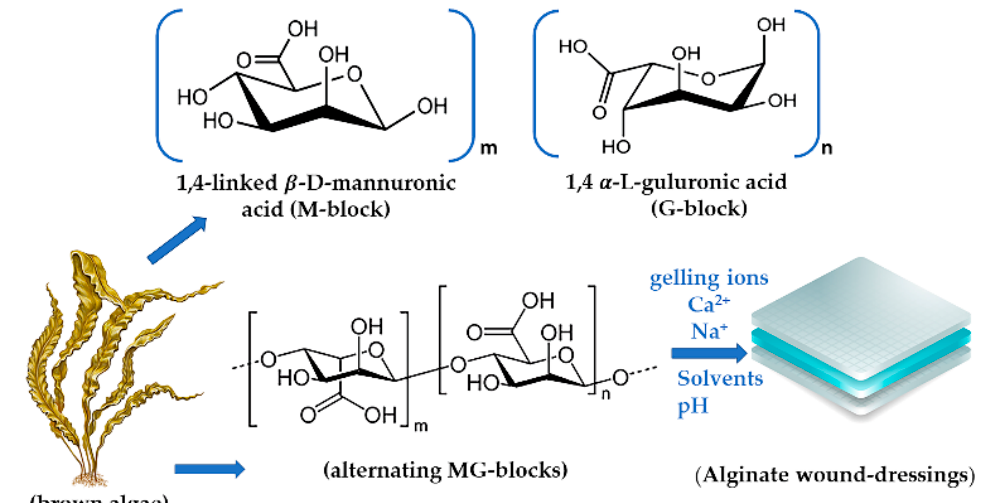
Figure 1. Alginates’ blocks in the polymeric chain.